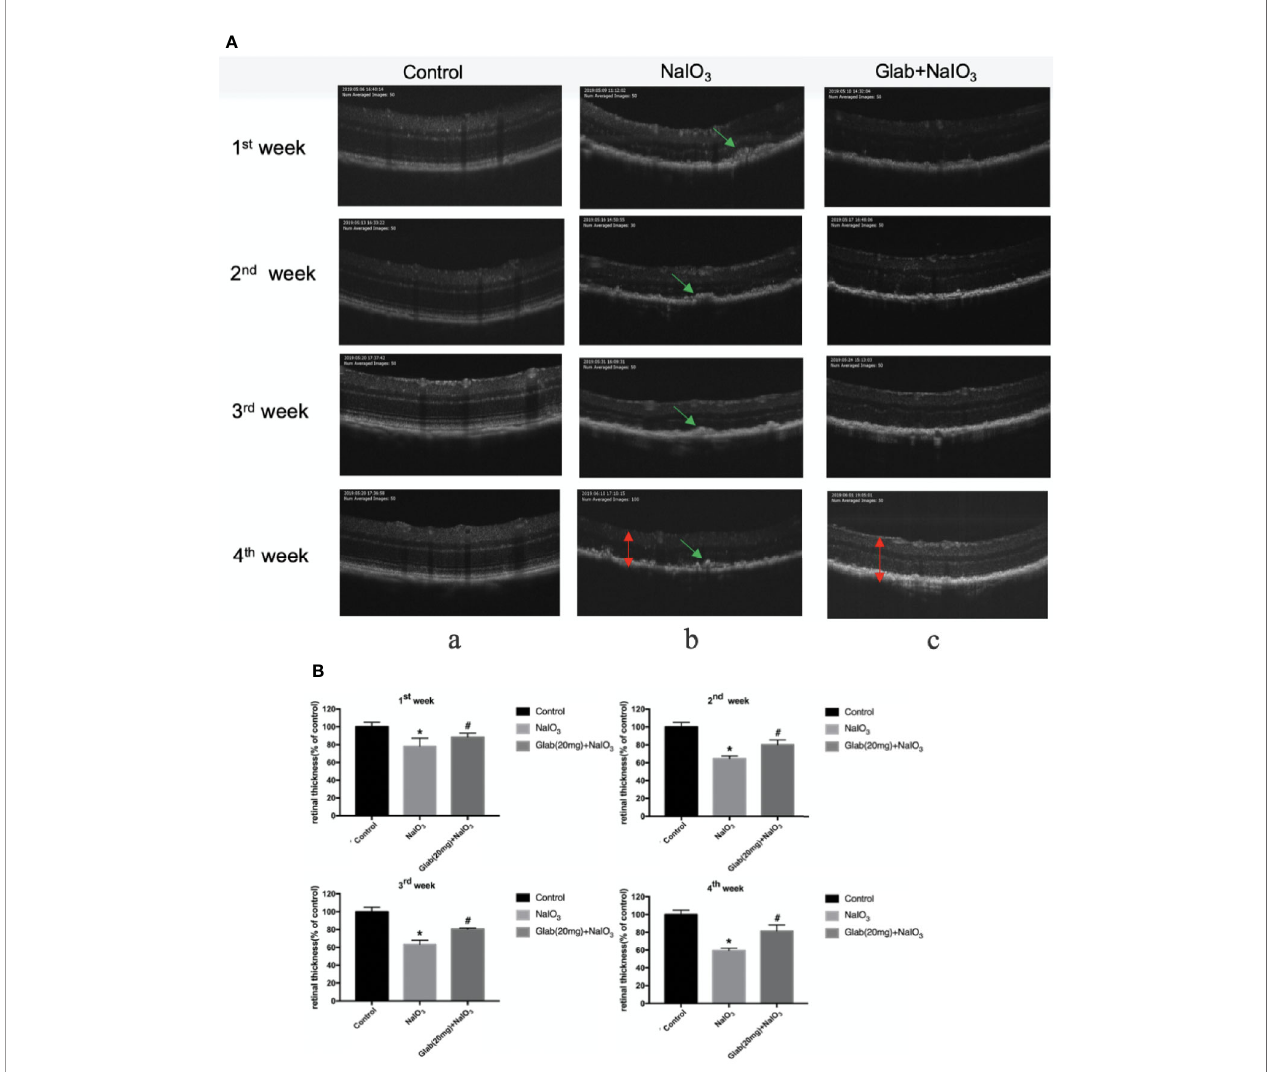
FIGURE 5 | Effects of Glabridin on the thinning of retina and deposits on the retinal pigment epithelial (RPE) layer of the retina monitored with non-invasive imaging in vivo . (A) Optical coherence tomography(OCT) measurement of the effects of Glabridin on the retinas of mice within four weeks after NaIO 3 injection and Glab treatment. a, retina of normal mice (Control); b, retina treated with NaIO 3 (25mg/kg) (NaIO 3 ); c, retina treated with Glabridin(20mg/kg) plus NaIO 3 (Glab(20mg)+NaIO 3 ). The changes in the thickness and layers of the retina could be seen. The shadows of deposits were signi fi cantly seen on the RPE layer in the NaIO 3 group, while they were not that obvious in the Glab+NaIO 3 group. (B) From the fi rst week to the fourth week, the thinning of the retina was worse week after week in the NaIO 3 group, compared with the control group (* P < 0.05). Although the degeneration became worse in the NaIO 3 group, the thickness and layers of the retina in the Glab +NaIO 3 group remained better than that of the NaIO 3 group throughout four weeks showing the most signi fi cant difference in the third week and fourth week, compared with the NaIO 3 group ( # P <